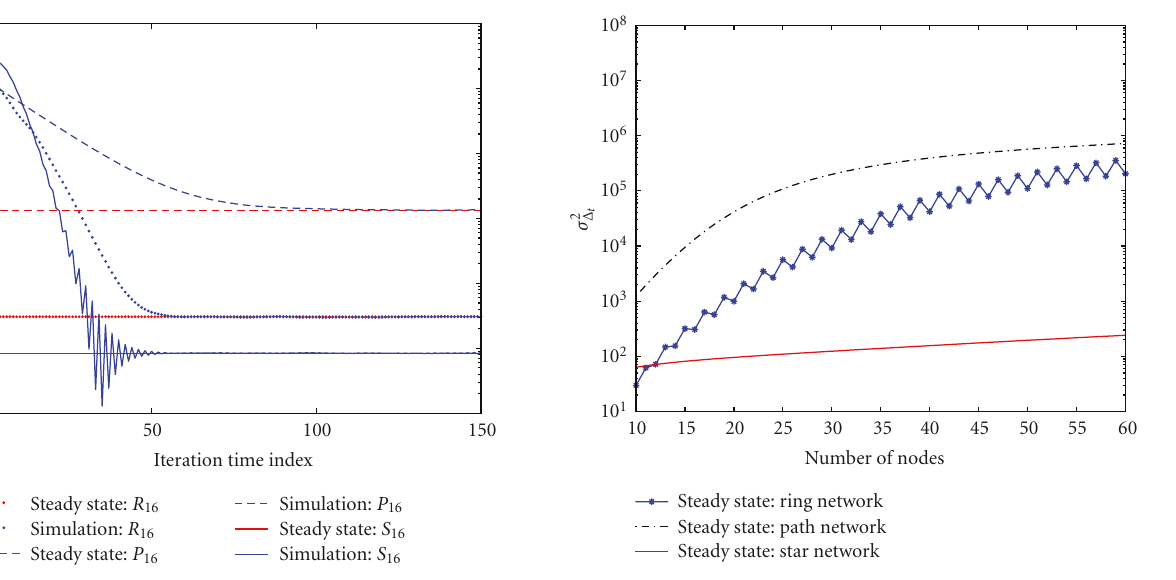
Figure 5: σ 2 as a function of the iteration time index for the Δ t SO-DCTS algorithm in structured networks ( R 16 , P 16 , S 16 ) with Gaussian delay.